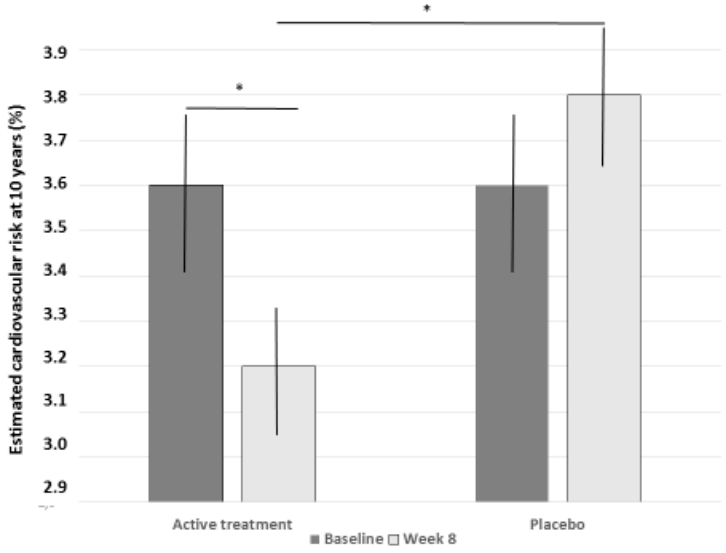
Figure 4. Change in estimated 10-year cardiovascular disease risk in the two treatment groups (post-hoc analysis; * p < 0.05).